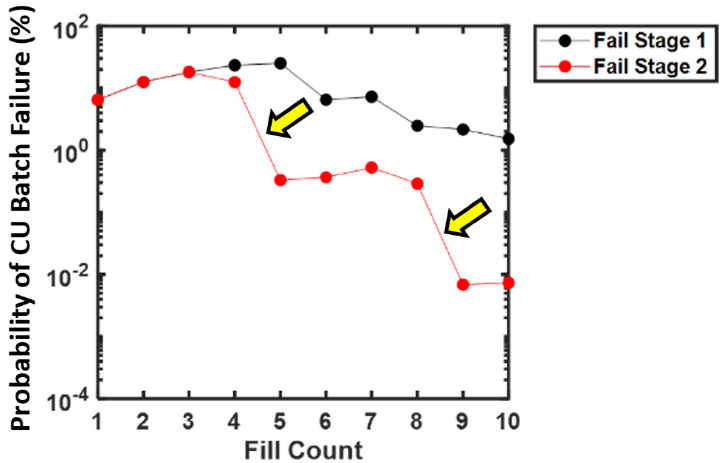
Figure 7. Probability of stage 1 or stage 2 CU failure for an example product having 2% composite RSD and 1% fill error probability, illustrating sharp probability transitions (arrows) occurring between sachet fill counts of 4 to 5 mini-tablets and 8 to 9 mini-tablets. Note these data are the same as in Figures 5 and 6 but represented in two dimensions for ease of visualization.